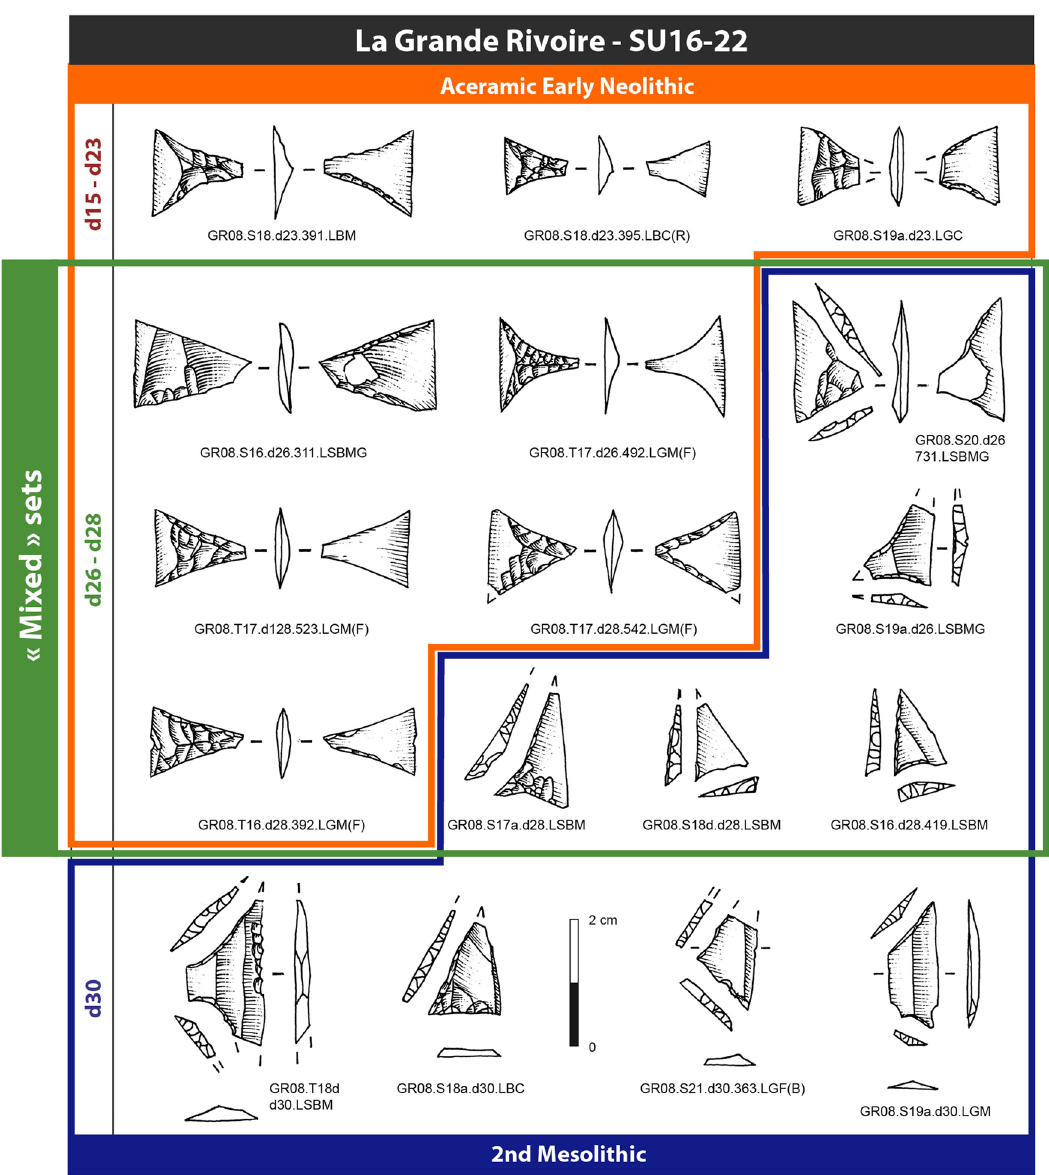
Figure 3: Arrowheads from layers d15 to d30 of the SU16 - 22 sector at La Grande Rivoire rock shelter. Drawings: Régis Picavet ( modi fi ed from Nicod et al., 2012 )